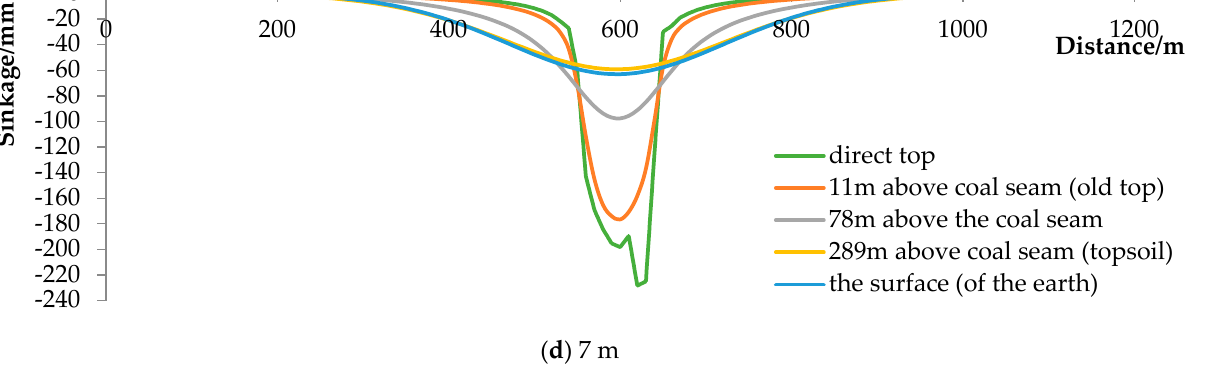
Figure 10. Overburden vertical deformation curve for ( a ) 4 m, ( b ) 5 m, ( c ) 6 m, and ( d ) 7 m. Table 4. Maximum overburden subsidence for different mining width conditions. Rock Location